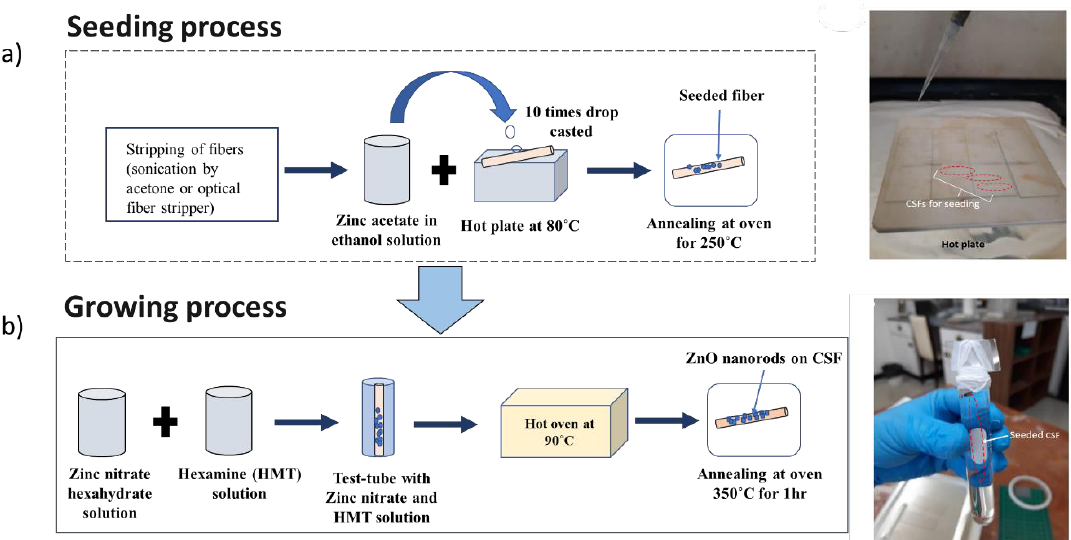
Figure 3. ( a ) ZnO seeding process showing the drop-casting of zinc acetate in ethanol onto heated CSFs; ( b ) growth of the ZnO nanorod process, showing the setup made of glass slides for suspending CSFs in the zinc nitrate hexahydrate and hexamine solution.